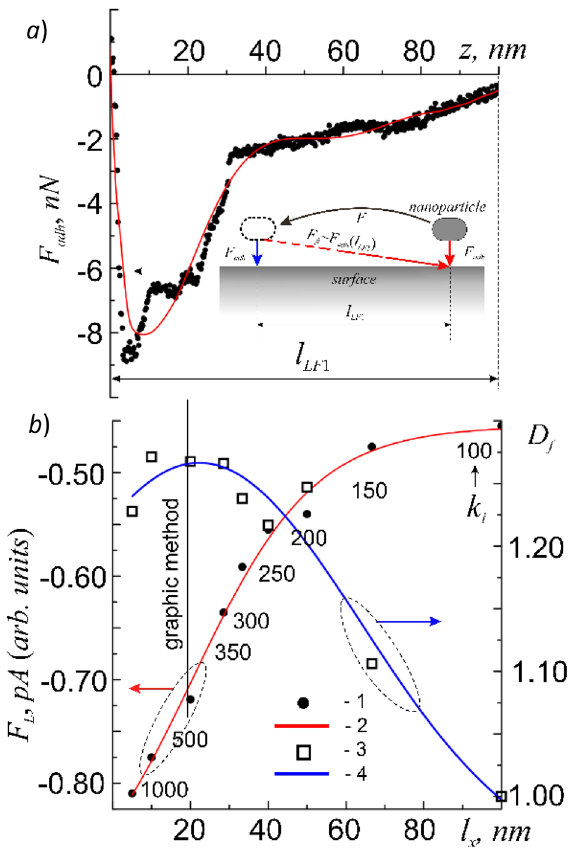
Figure 5. Dependence of the absolute values F adh = F adh ( z ) for the probe-surface of the cell membrane system at F const = 0 (points—experiment, line—approximation) ( a ), and relative averages over the 5 × 5 μm region of the values 〈 F L ( l x ) 〉 , or 〈 F adh ( k i ) 〉 (points 1—experiment, line 2—approximation) and D f = D f ( l x ) when moving the probe along the surface along l x (points 3—experiment, line 4—approximation)